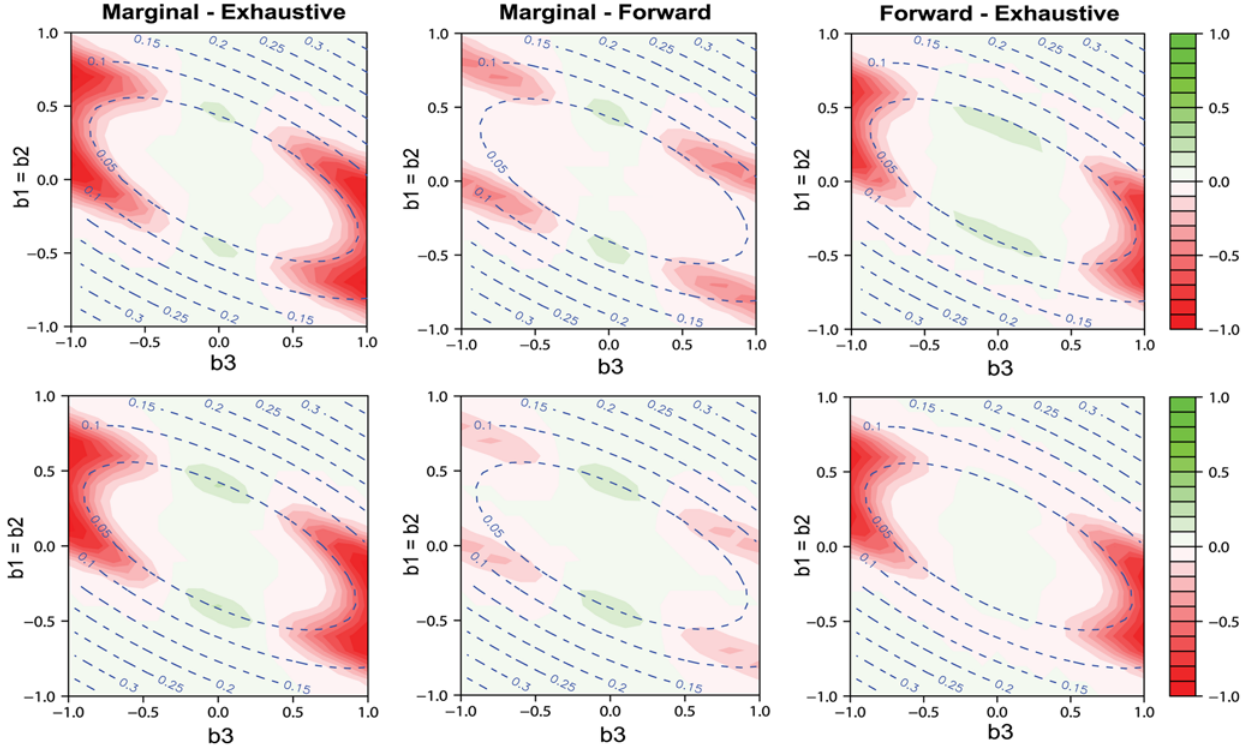
Figure 2. Comparisons among model selection power for detecting the true model or both true SNPs in marginal search over genetic model space. The power differences between marginal search and exhaustive search in the left column, between marginal search and forward search in the middle column, and between forward search and exhaustive search in the right column. Green areas indicate positive values of difference, and red areas indicate negative values of difference. We consider genetic models with the main effects b 1 = b 2 varying from 2 1 to 1 and the epistatic effect b 3 varying from 2 1 to 1. The allele frequency q j =0.3, j =1, …, p , and the false discovery number R is set to be 1 in row 1 and 10 in row